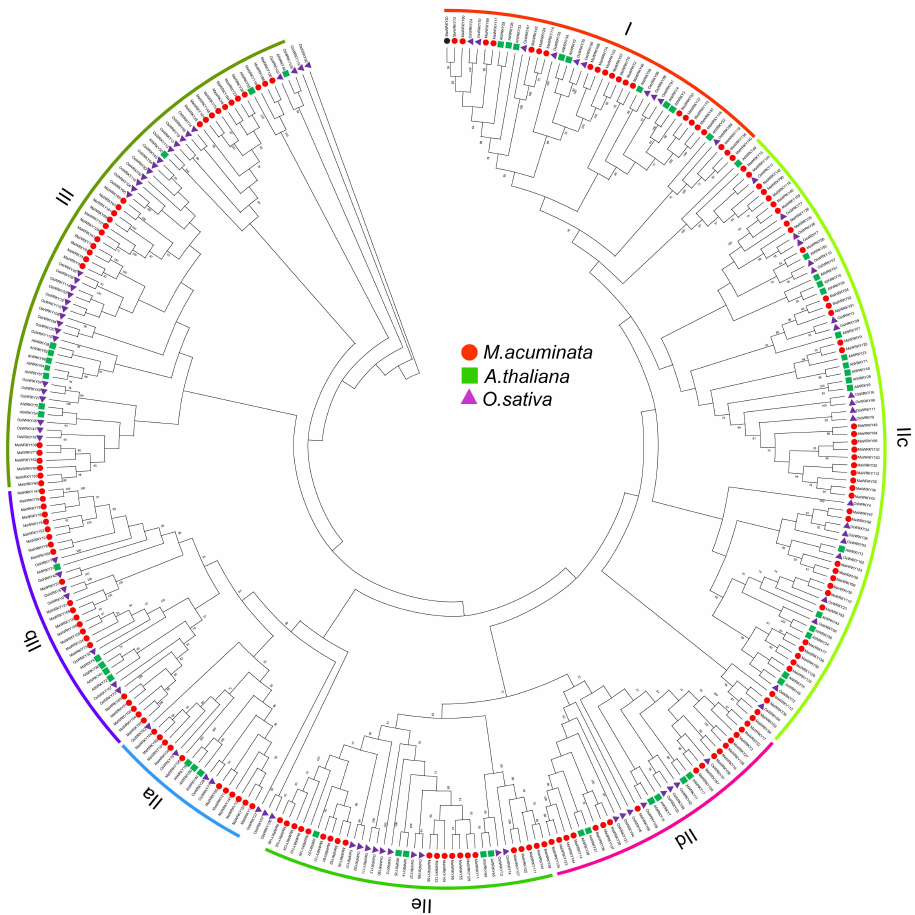
Figure 1. Phylogenetic tree of WRKY TFs constructed based on WRKY domains from Arabidopsis (in green and prefised by At) and rice (in purple and prefised by Os), and M. acuminata (in red and prefised by